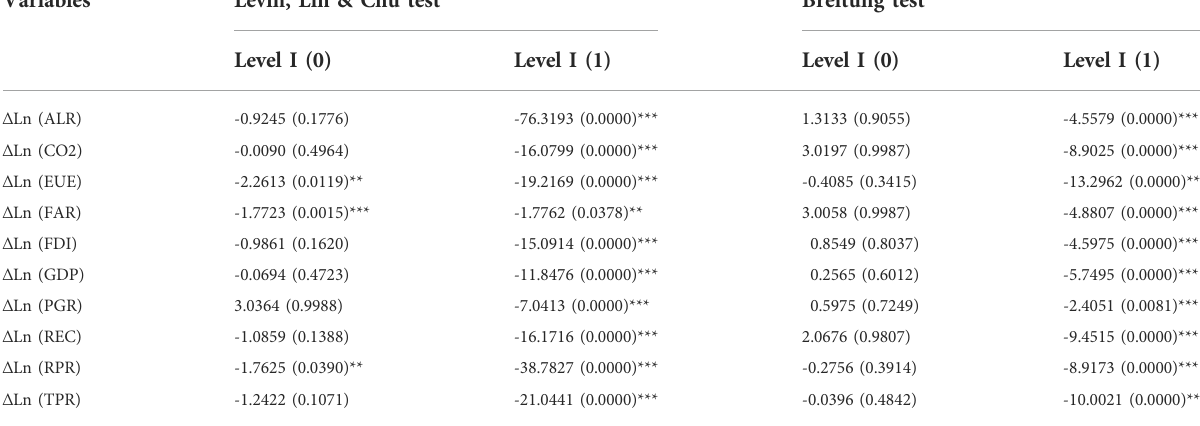
TABLE 3 Panel unit root